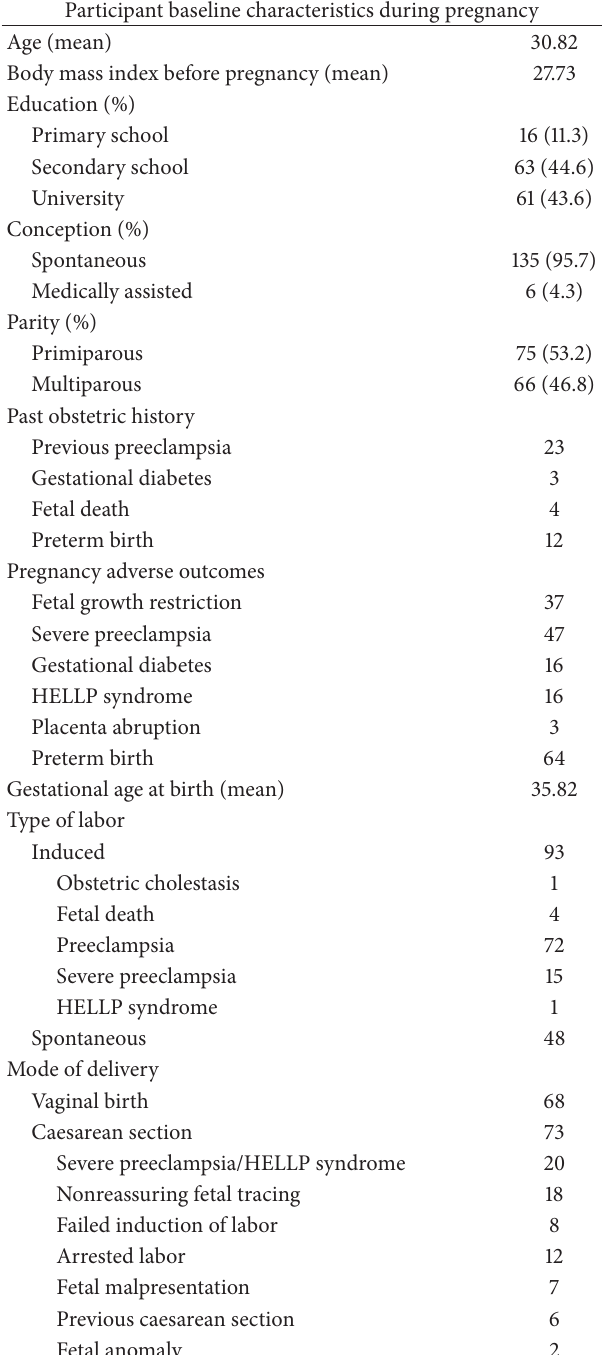
Table 1: Participant baseline characteristics during